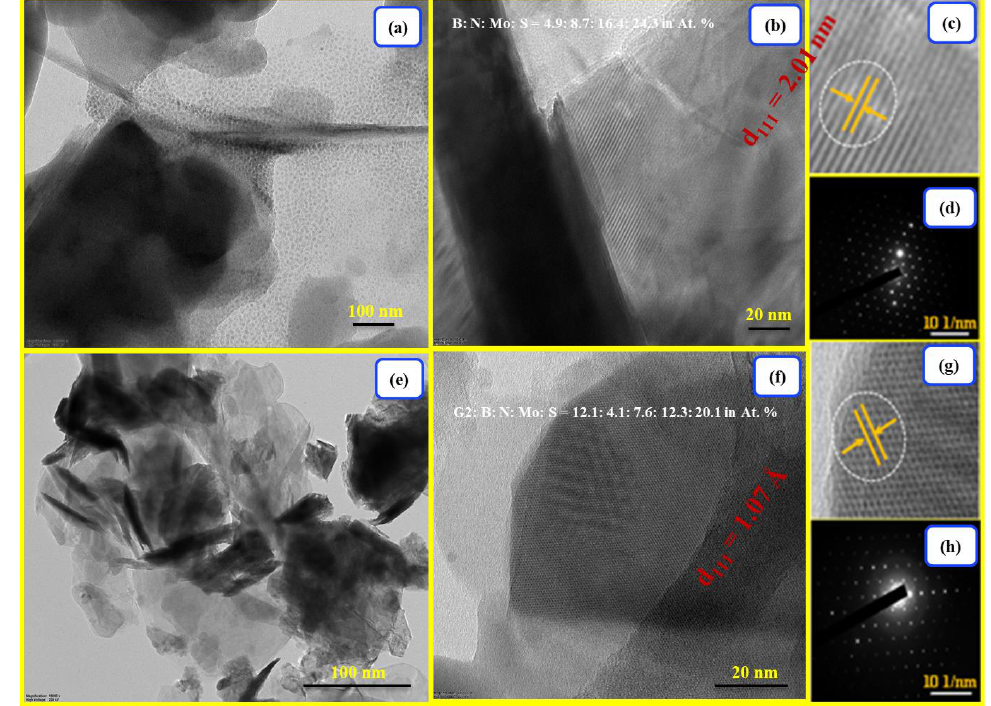
Figure 4. HRTEM images of ( a – d ) h-BN/MoS 2 and ( e – h ) Ge/h-BN/MoS 2 .